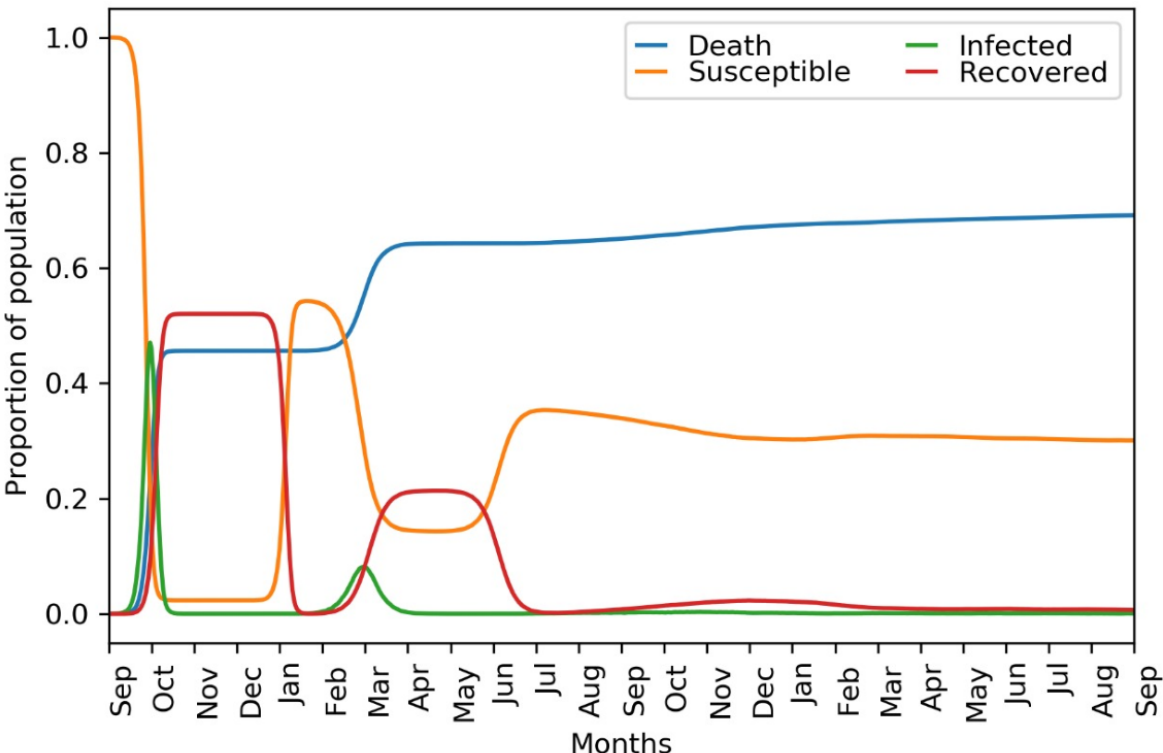
Figure 3. SIR adjusted dynamic of Spanish Flu evolution along the period recorded for its occurrence in Manaus. We assumed only one variant of H1N1 and showed the variables responses to the simulation of the population size and published parameters of mortality and transmissibility for the Influenza 1918-19 (see the text for